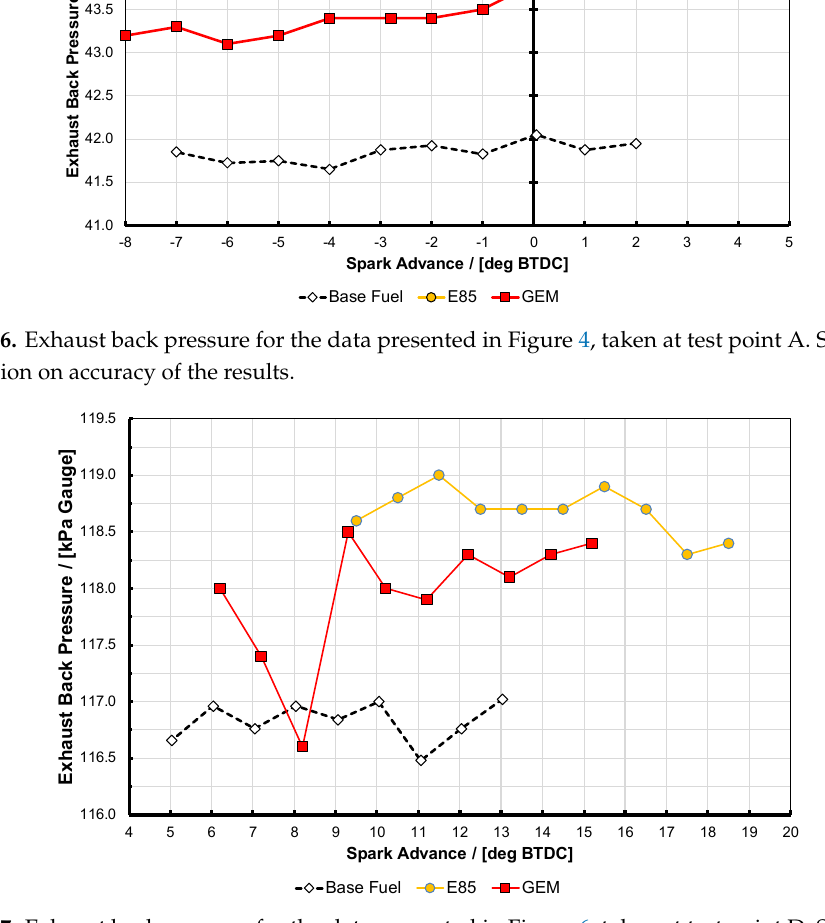
Figure 7. Exhaust back pressure for the data presented in Figure 6, taken at test point D. See text for discussion on accuracy of the results.